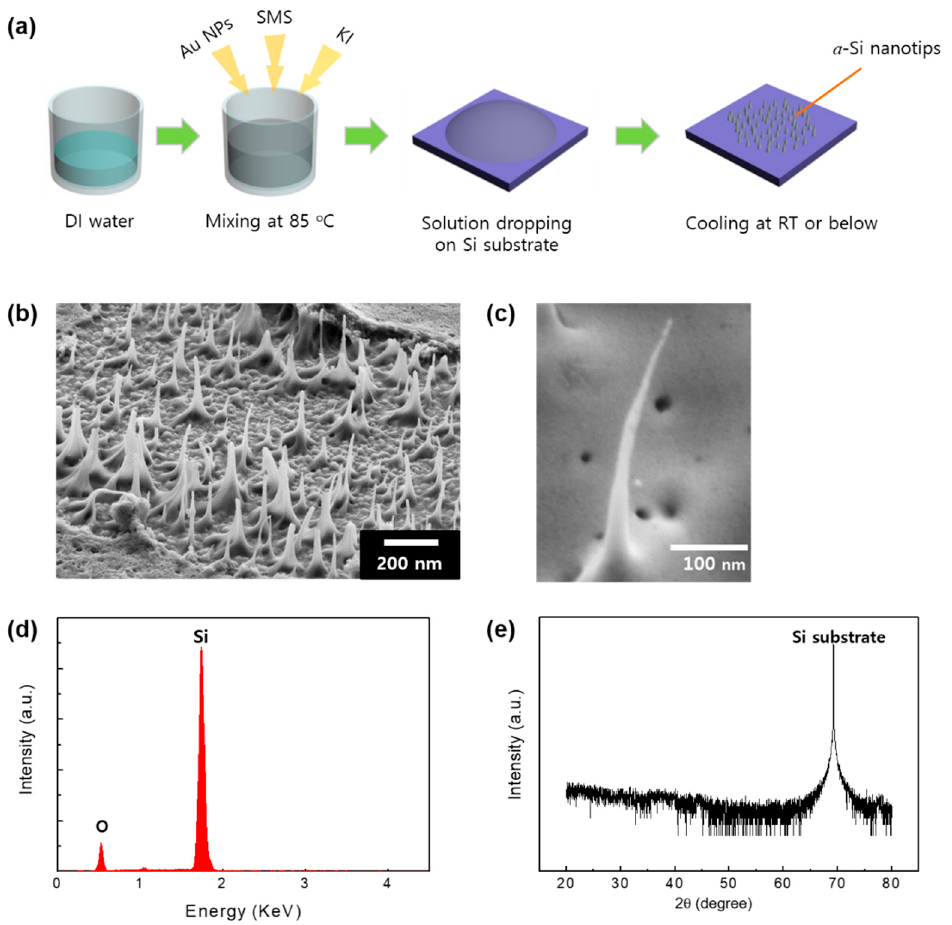
Figure 1. ( a ) Schematic growth procedure of amorphous Si ( a -Si) nanotips on a Si substrate. ( b ) SEM image of the sample surface. ( c ) Magnified scanning electron microscopy (SEM) image and ( d ) corresponding energy-dispersive X-ray spectrometry (EDX) spectrum of a single a -Si nanotip. ( e ) X-ray diffraction (XRD) pattern of a -Si nanotips.